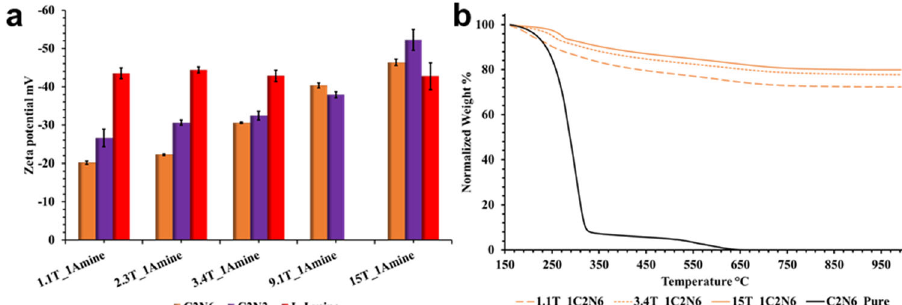
Fig. 4 Zeta potential and TGA of polyamine – silica particles. a Average zeta potential obtained for silica particles (1.5 mg/mL) grown at different mole ratios. Samples were measured thrice ( n = 3) in 22 mM polyamine solution (error bars represent standard deviation). b Normalized TGA curves of silica particles grown at increasing z TEOS_1C 2 N 6 mole ratio obtained by heating the samples in air. Samples were heated from RT to 1000 °C at 20 °C/min. Sample weight-loss was normalized from 160 °C to account for loss of adsorbed